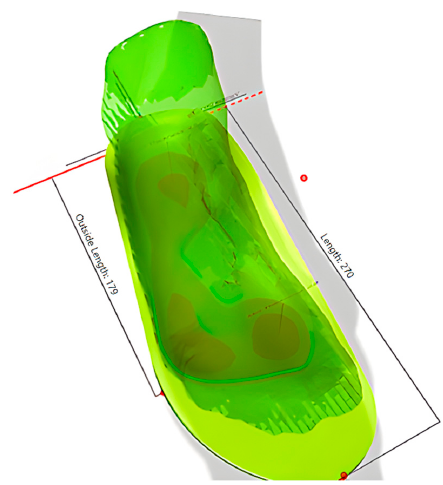
Figure A1. Total insole length.